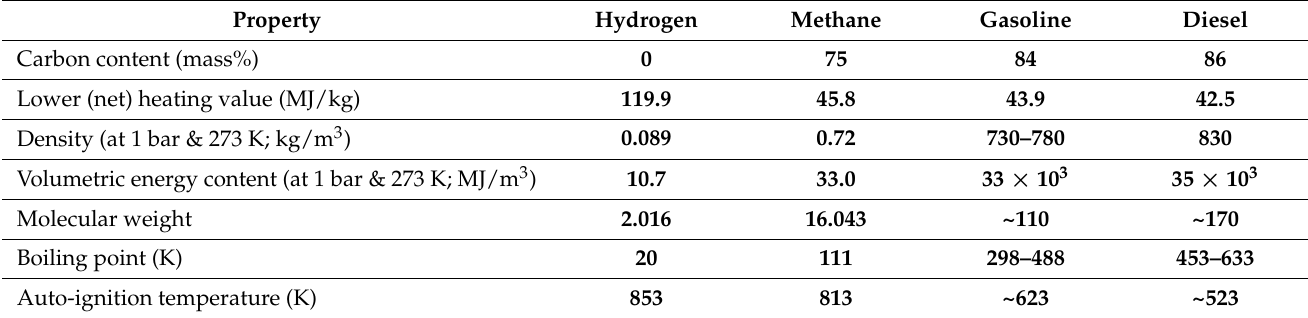
Table 2. Hydrogen properties compared with gasoline, diesel, and methane [11,15,33,34].